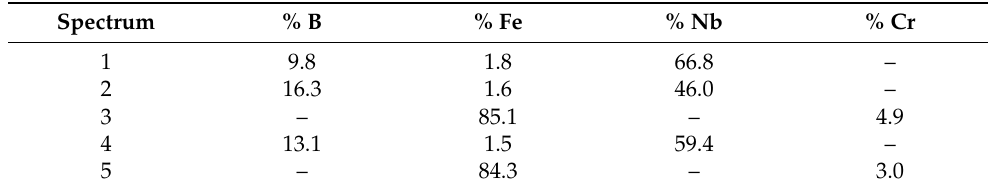
Table 6. Results of the micro-analysis carried out with SEM-EDX. Spectrums highlighted in Figure 2 (weight %). Due to the low fluorescence yield of boron, its analysis by EDX shows a high error. Therefore, the boron analysis should be considered “semi-quantitative”.